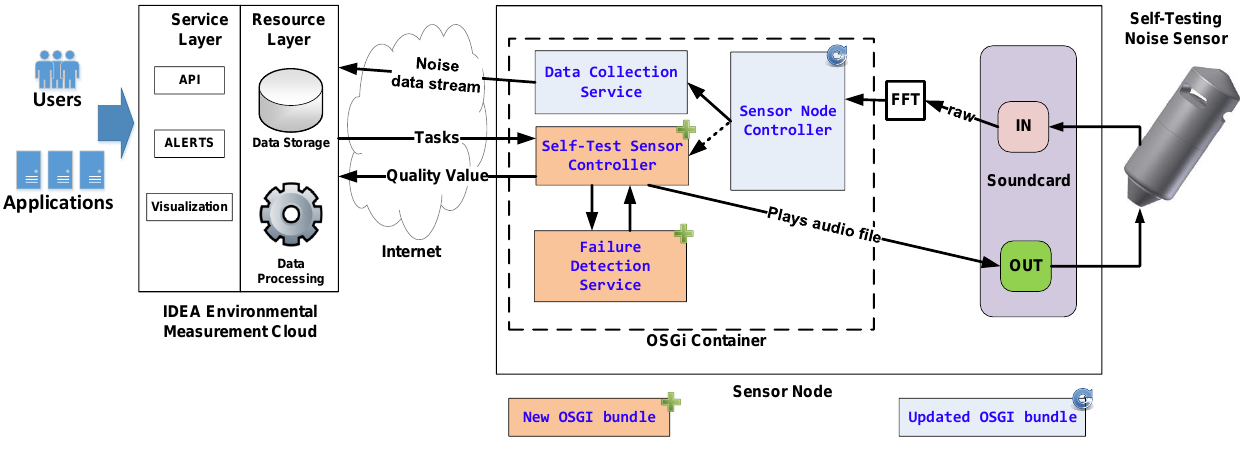
Figure 5. The software modules that drive the self-test functionality run on-board the sensor node. After a self-test, the Self-Test Sensor Controller module sends a quality value to the IDEA Environmental Measurement Cloud where the value is stored and decisions such as alerting are